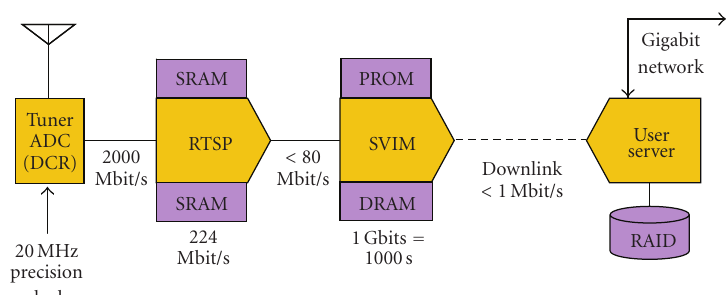
Figure 3: System architecture for satellite receiver system. The ADC accepts a 20MHz clock and produces a 120 Msps 16 bit data stream. The FPGA-based RTSP processes the RF stream into full-bandwidth snapshots and data products. The radiation-hardened flight computer (SVIM) provides command and control as well as packaging data for transmission to the ground.